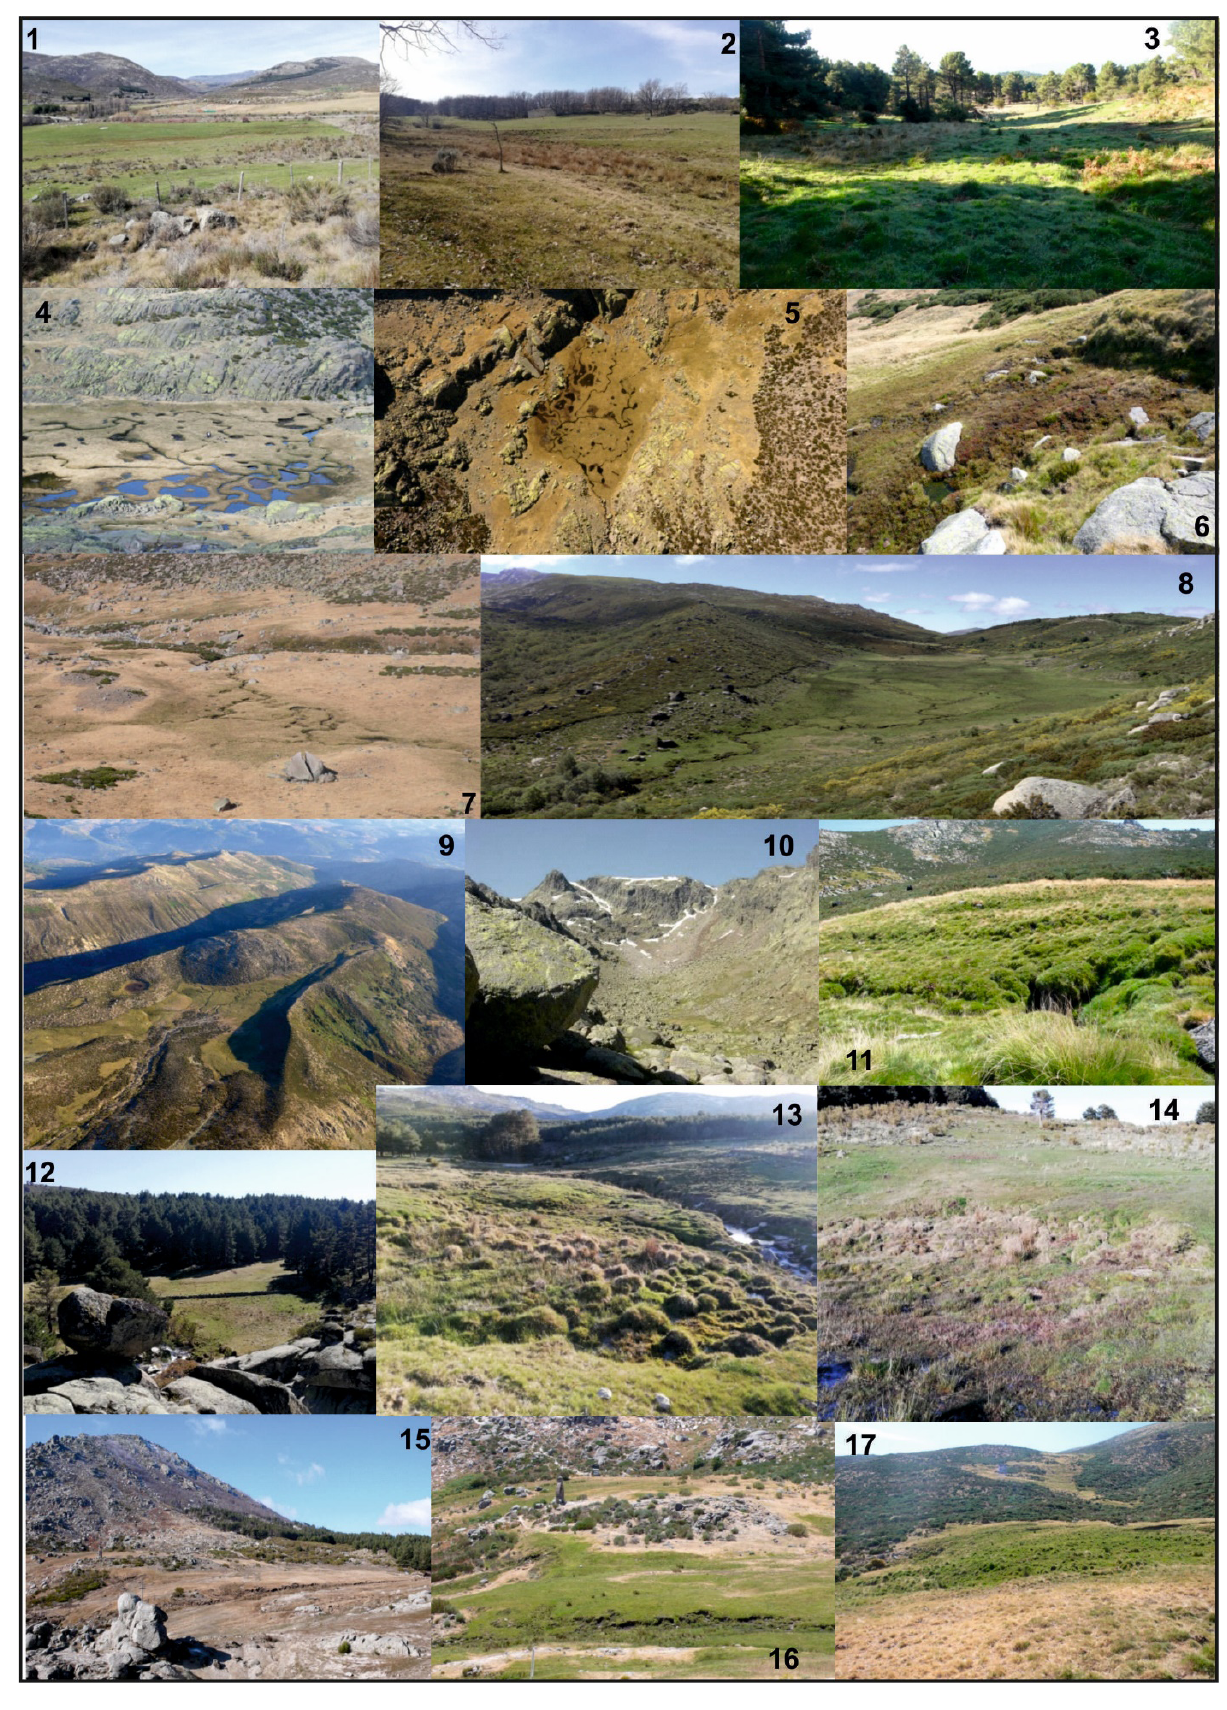
Figure 2. Confined peatland typological groups according to the r geomorphological location and the origin of the landform (see Table 1): RW-type (1, Venta del Obispo; 2, Arrelobo E; 3, Fuente del Pino Blanco); GC-type (4-5, Lagunillas); GV-type (6, Prado de las Pozas; 7, Prado Puerto-Prado de Barbellido); MD-type (8, Navamuño; 9, Cervunal); MGN-type (10, Hoya de las Berzas); NC-type (11, Puerto del Peón); NT-type (12, Chorreras del Tormes; 13-14, Cañada de las Trampaleras; 15-16, Puerto del Pico; 17, Collado